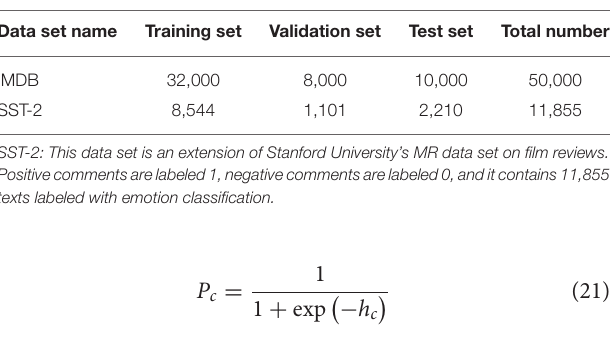
TABLE 1 | Data of the experiment in this